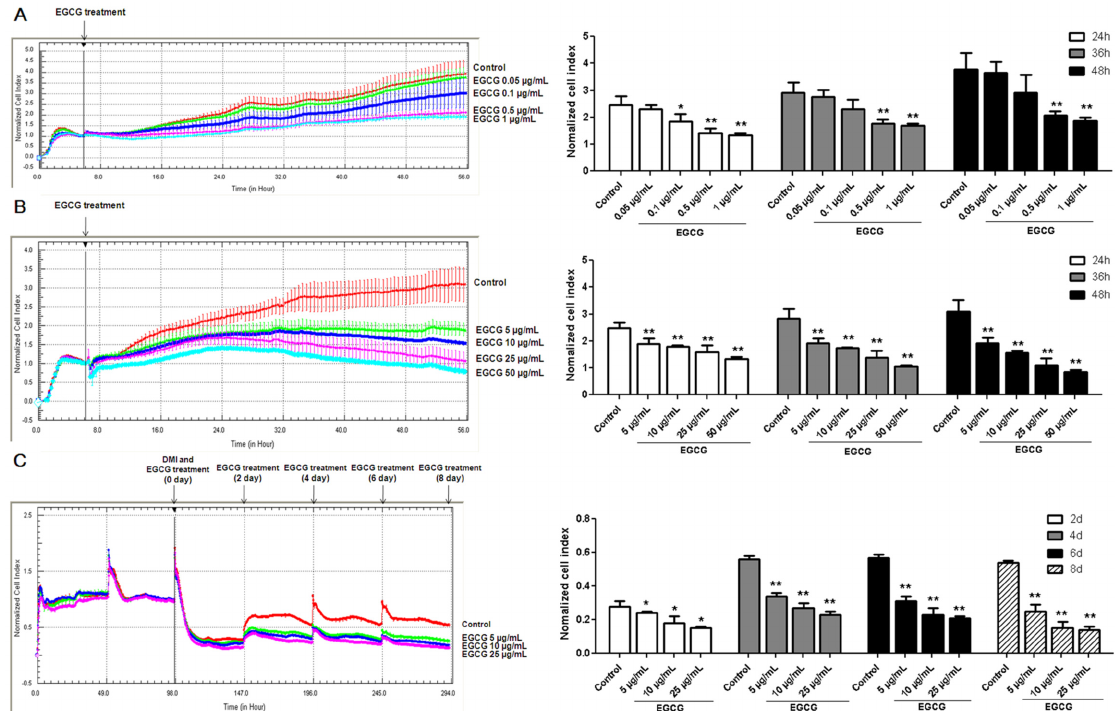
Figure 1. Effects of ( − ) ‐ Epigallocatechin ‐ 3 ‐ gallate (EGCG) on the proliferation and differentiation in 3T3 ‐ L1 cells. The effects of EGCG at physiologically attainable concentrations ( A ) and higher concentrations ( B ) on the proliferation of 3T3 ‐ L1 preadipocytes. 3T3 ‐ L1 preadipocytes were seeded into E ‐ plates at equal densities of 6000 cells/well. For each concentration, three replicates on a 16 ‐ well E ‐ plate were performed. Impedance at well bottoms was measured every 15 min for 48 h and the impedance signal was analyzed by normalizing data of each single well to the first measurement after EGCG treatment; ( C ) The effects of EGCG on differentiation of 3T3 ‐ L1 cells. 3T3 ‐ L1 preadipocytes were seeded into E ‐ plates at equal densities of 10,000 cells/well. The medium with or without EGCG was changed every 2 days. Changes in impedance were normalized to the time of differentiation medium (DMI) addition and were given as a dimensionless normalized cell index (CI) values. Normalized cell index reflects the cell density. Values are means ± standard deviation (SD), n = 3. * p < 0.05, ** p < 0.01 vs. the control.